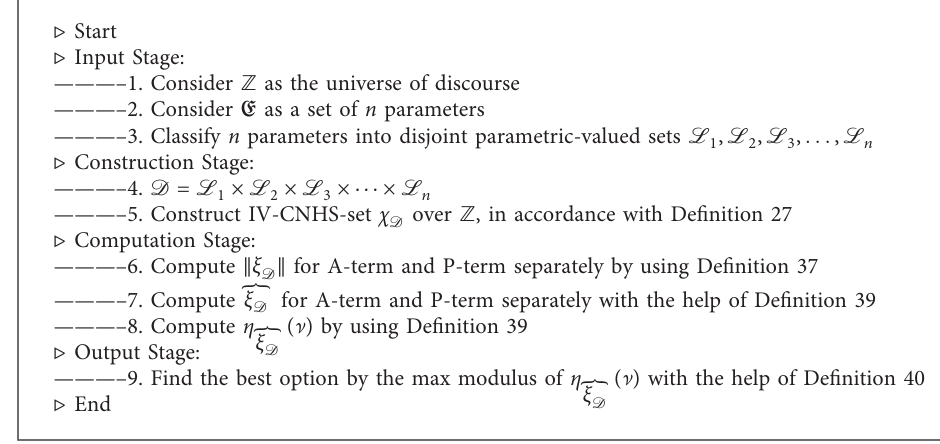
A LGORITHM 2 : Decision-support algorithm based on aggregations of